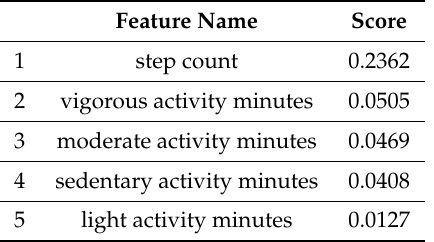
Table 2. Correlation coefficient feature ranking.